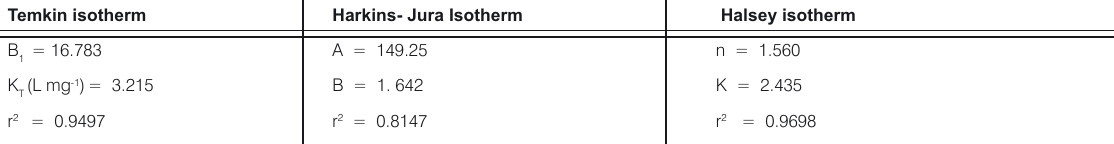
Table 1b. Equilibrium Isotherm Parameters of sorption of CR by